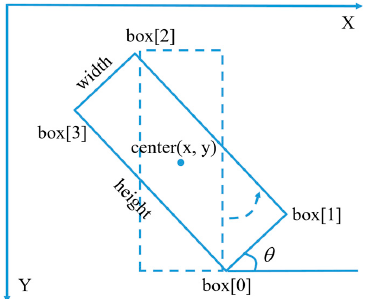
Figure 4. General representation of bounding box.